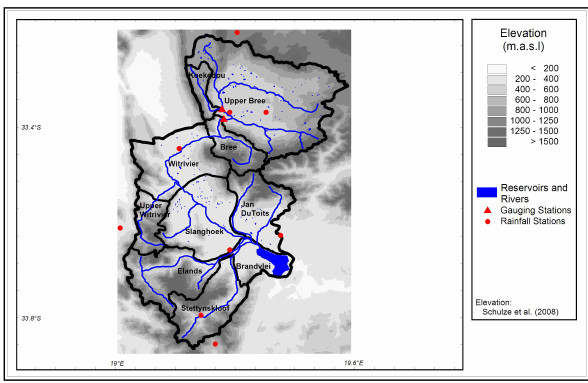
Fig. 5. Upper Breede Water Management